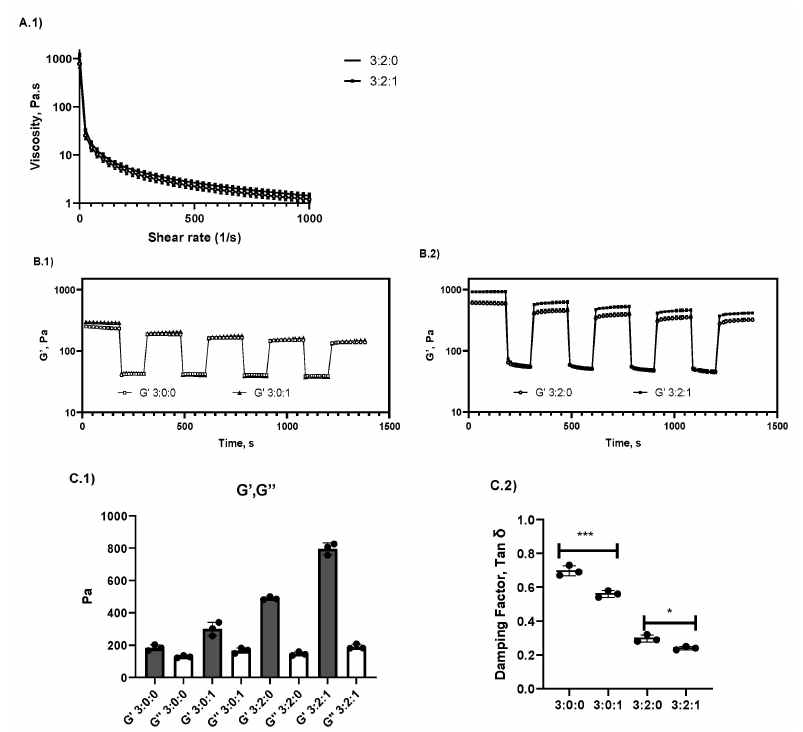
Figure 4. Dynamic viscosity evaluation by increasing the shear rate. The average values obtained (n = 3) CHT/PCD/CN hydrogel formulations 3:2:0 and 3:2:1 are shown ( A.1 ). (( B.1 , B.2 )) elastic modulus recovery evaluation at 25 ◦ C after a low (1%) and high (500%) shear strain (( C.1 , C.2 )) Study of viscoelastic modulus (G (cid:48) and G”) and damping factor at 37 ◦ C in the LVR at t = 10 min (*** = p < 0.001, * = p <